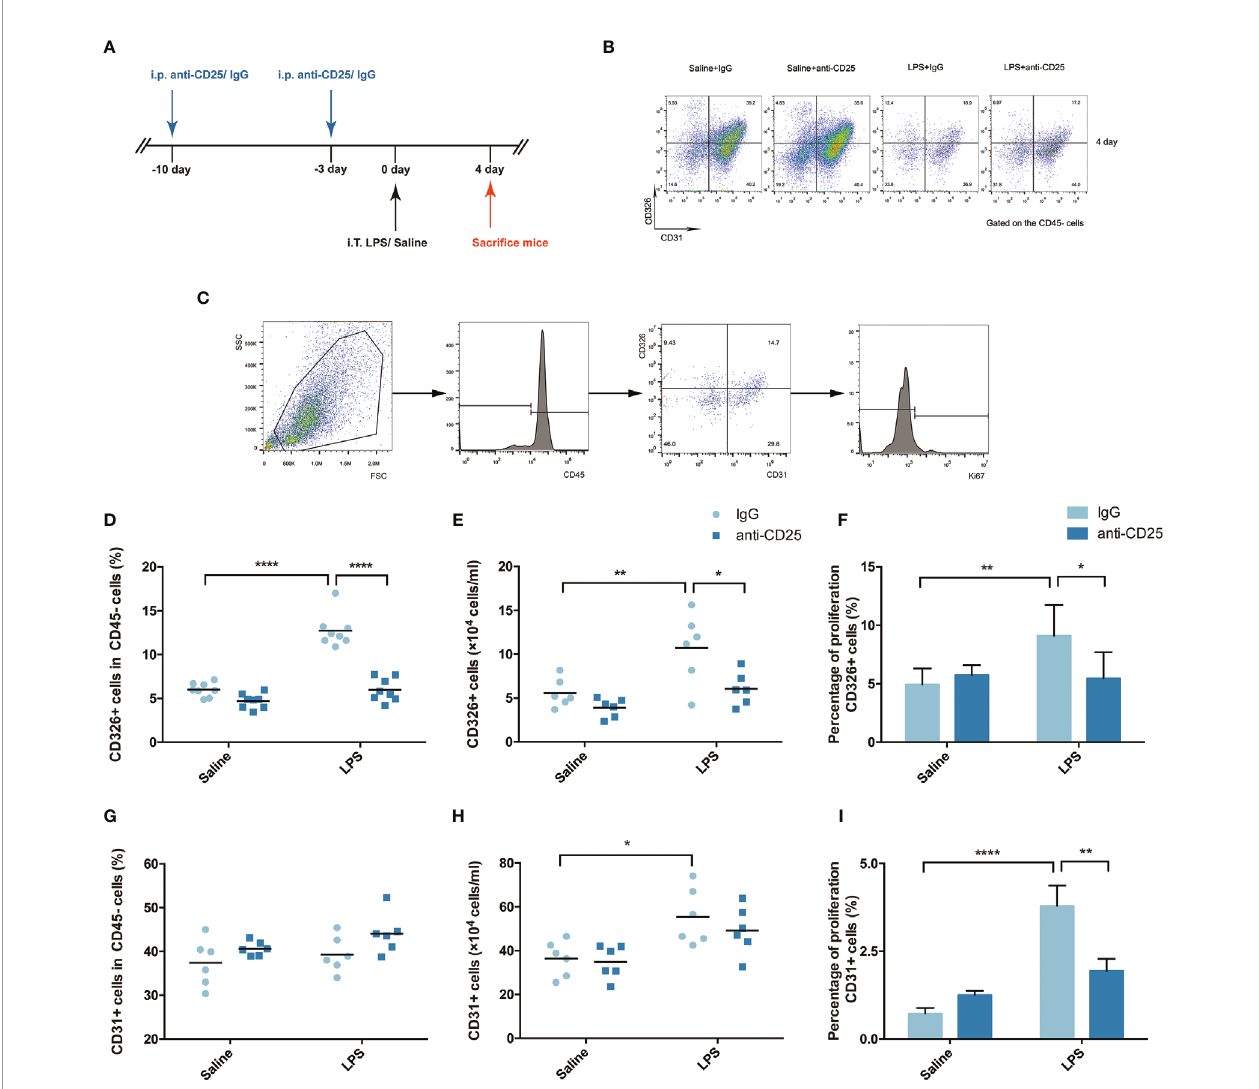
FIGURE 3 | Treg depletion damages pulmonary epithelial regeneration. To deplete Treg cells, BALB/c mice were treated with an i.p. injection of anti-CD25 antibody on day 10 before LPS administration and 7 days thereafter. The mice were sacri fi ced 4 days after LPS exposure. (A) Schematic diagram of the experimental design. (B) Cyto fl uorometric dot plots of CD45 − CD326+CD31 − epithelial cells or CD45 − CD326 − CD31+ endothelial cells 4 days after injury. Numbers depict the fraction of CD45 − cells within the designated gate. (C) Gating strategy to analyze the proliferation of epithelial cells/endothelial cells. Single-cell suspensions were prepared from injured or uninjured lungs, and Ki67+ epithelial cells were detected by fl ow cytometry. (D) Fraction of pulmonary epithelial cells (CD45 − CD326+CD31 − ) in lung suspensions. (E) Number of pulmonary epithelial cells (CD45 − CD326+CD31 − ) in lung suspensions. (F) Flow cytometric analysis of the proliferation of pulmonary epithelial cells. Proliferation was monitored by the nuclear marker Ki67. (G) Fraction of pulmonary endothelial cells (CD45 − CD326 − CD31+) in lung suspensions. (H) Number of pulmonary endothelial cells (CD45 − CD326 − CD31+) in lung suspensions. (I) Flow cytometric analysis of the proliferation of pulmonary endothelial cells. For all panels: mean ± S.D. *p ≤ 0.05; **p ≤ 0.01; and ****p ≤ 0.0001 for one-way analysis of variance with the Bonferroni post hoc test for multiple t-tests. A value of p < 0.05 was considered statistically signi fi cant. n = 6 mice per